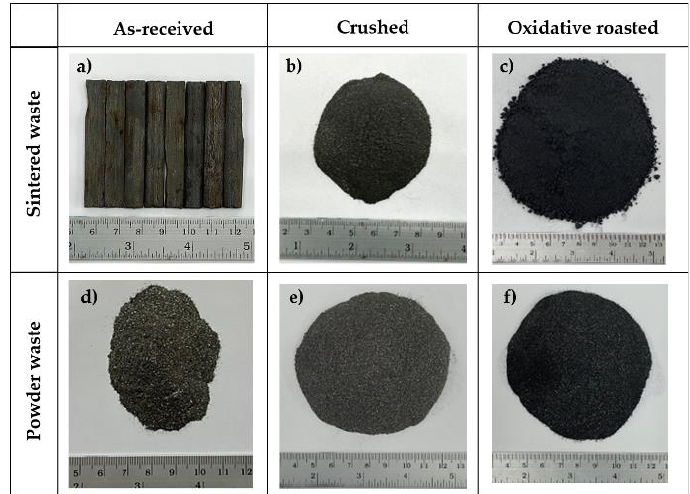
Figure 1. Manufacturing NdFeB magnet wastes obtained from sintering and powder processing; in the ( a , d ) as-received, ( b , e ) after crushing plus sieving under #70 mesh and ( c , f ) after oxidative roasting at 600 °C for 1 h, for sintered and powder wastes respectively. Table 1. Chemical composition of manufacturing NdFeB magnet wastes analyzed by ICP-OES.